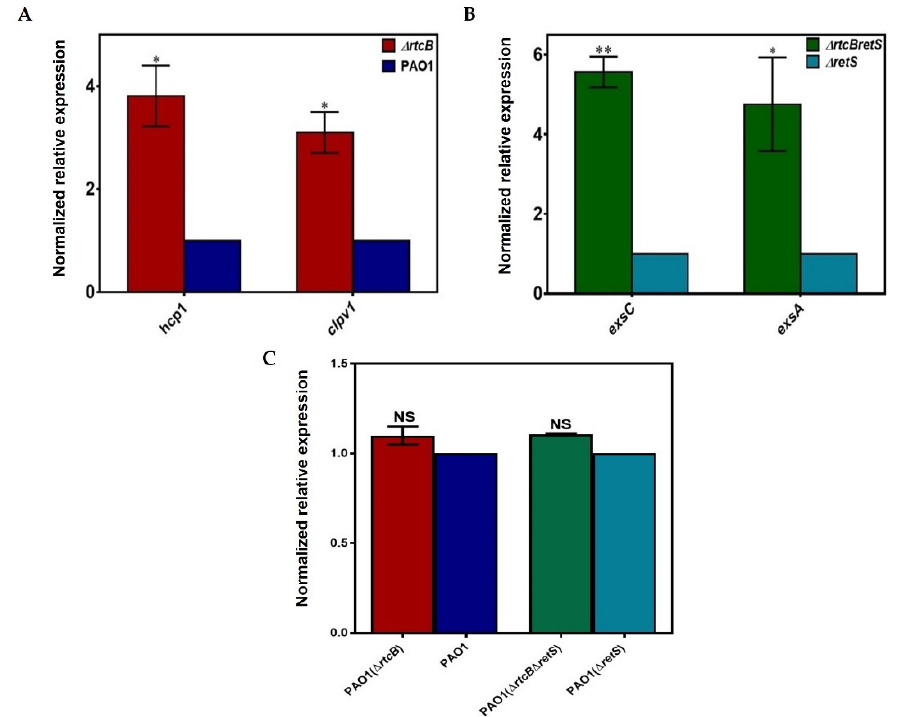
Figure 4. Confirmation of RtcB effect on rsmA and genes associated with H1-T6SS and T3SS. The mRNA levels of H1-T6SS and T3SS genes were quantified by qPCR. ( A ) The transcription levels of clpV1 and hcp1 were significantly higher in PAO1( ∆ rtcB ) than in PAO1 (* p < 0.05). ( B ) The expression of exsA and exsC was upregulated considerably in PAO1( ∆ rtcB ∆ retS ) compared to PAO1( ∆ retS ) (* p < 0.05 and ** p < 0.01). ( C ) The expression level of rsmA remained unchanged in all strains, confirming the RNAseq data. Expression levels were normalized to the levels of housekeeping gene rpoD and presented as a fold change relative to the control (=1). Data were analyzed using unpaired Student’s t -test. Two independent experiments were performed in triplicate. NS p > 0.05.